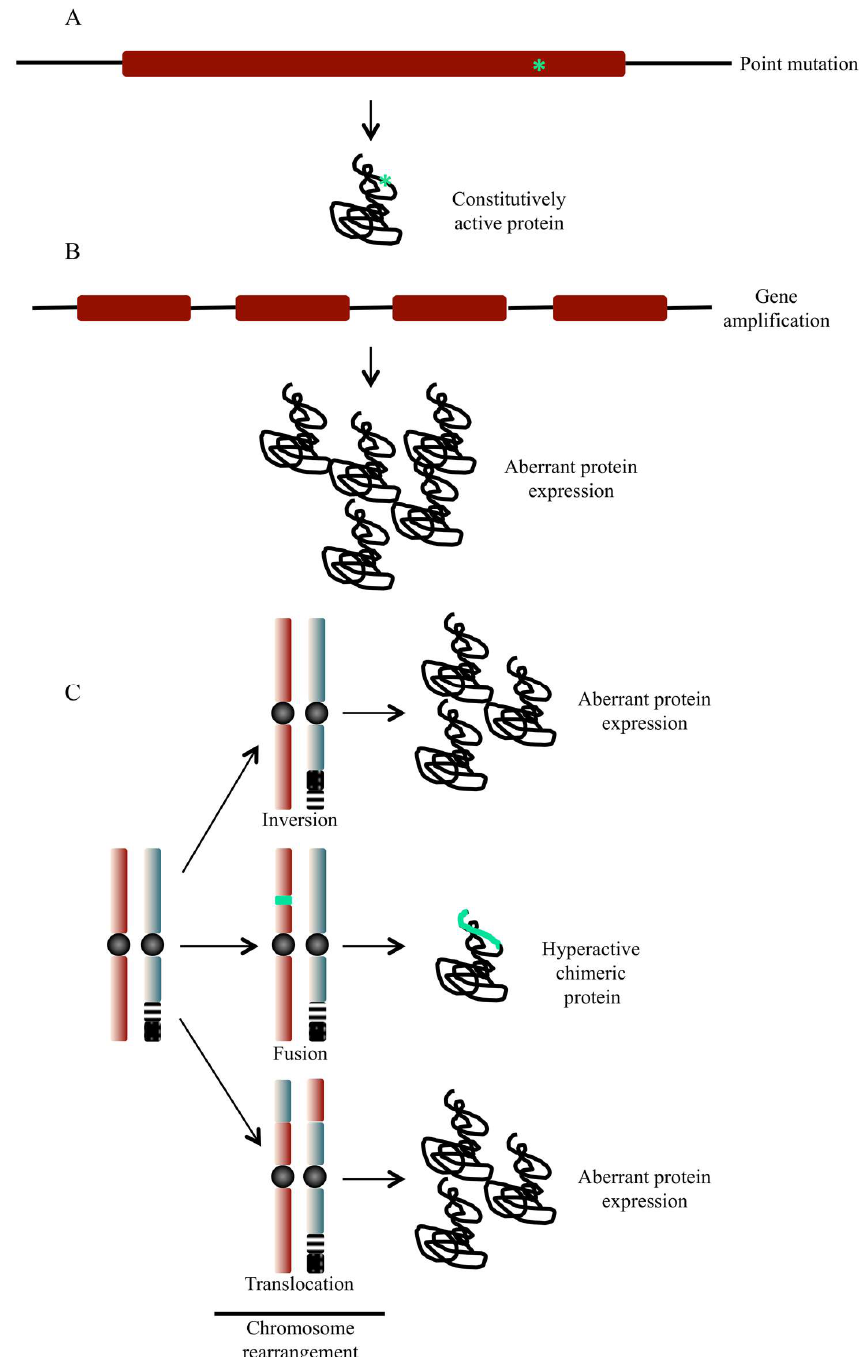
Figure 2. Possible alterations of protein kinase-coding genes and their outcome. ( A ) Point mutations are capable of activating a proto-oncogene product resulting in the expression of a constitutively active protein kinase. ( B ) In addition to nucleotide substitution, gene amplification that results from amplification of chromosomal fragments can result in aberrant expression of genes coding for protein kinases. This can result in uncontrolled activation of signalling pathways controlled by the overexpressed protein kinases. ( C ) Alteration in the structure of chromosomes can take several forms including translocation, inversion, deletion and insertion of genetic material. Chromosome abnormalities can result in the expression of higher levels of a protein, chimeric hyperactive proteins or loss of tumour suppressor gene products.